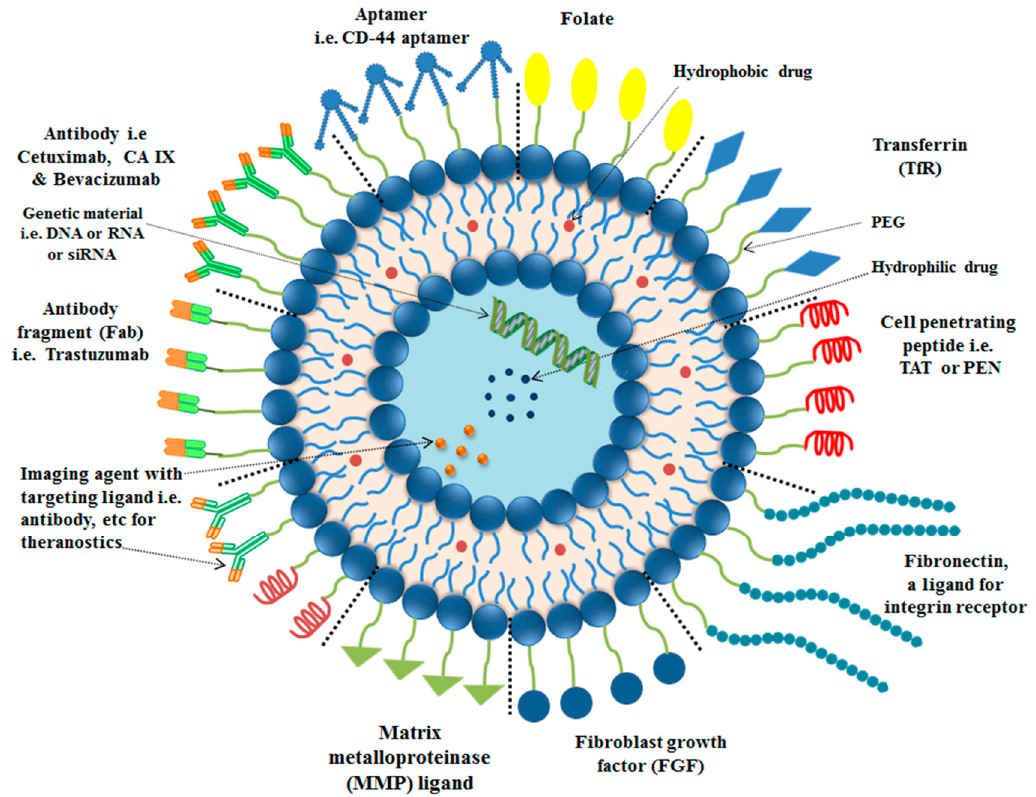
Figure 4. Surface functionalized liposome (summary) with various targeting ligands for enhanced delivery of payload at tumor site.